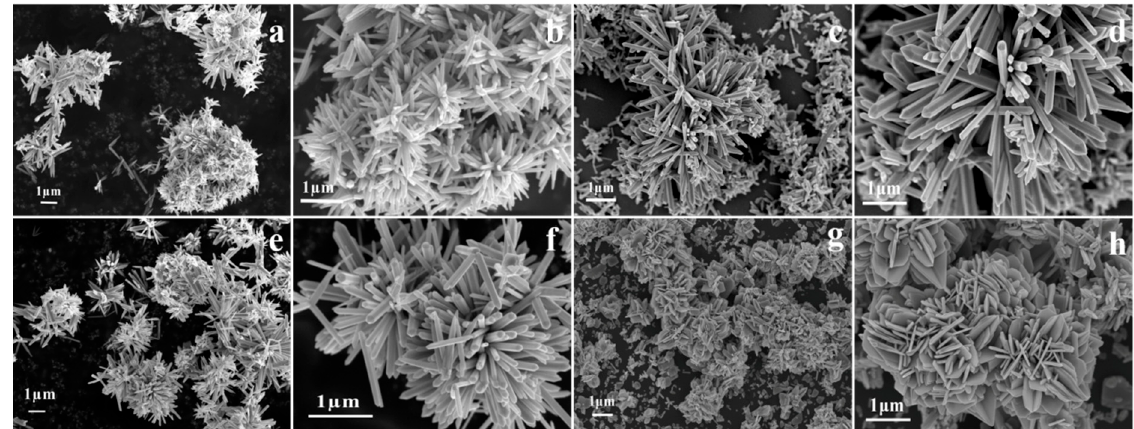
Figure 2. SEM micrographs of ZnO nano-rods: ( a , b ): 0.8 g CTAB; ( c , d ): 1.0 g CTAB; ( e , f ): 1.2 g CTAB and ( g , h ): 1.4 g CTAB.